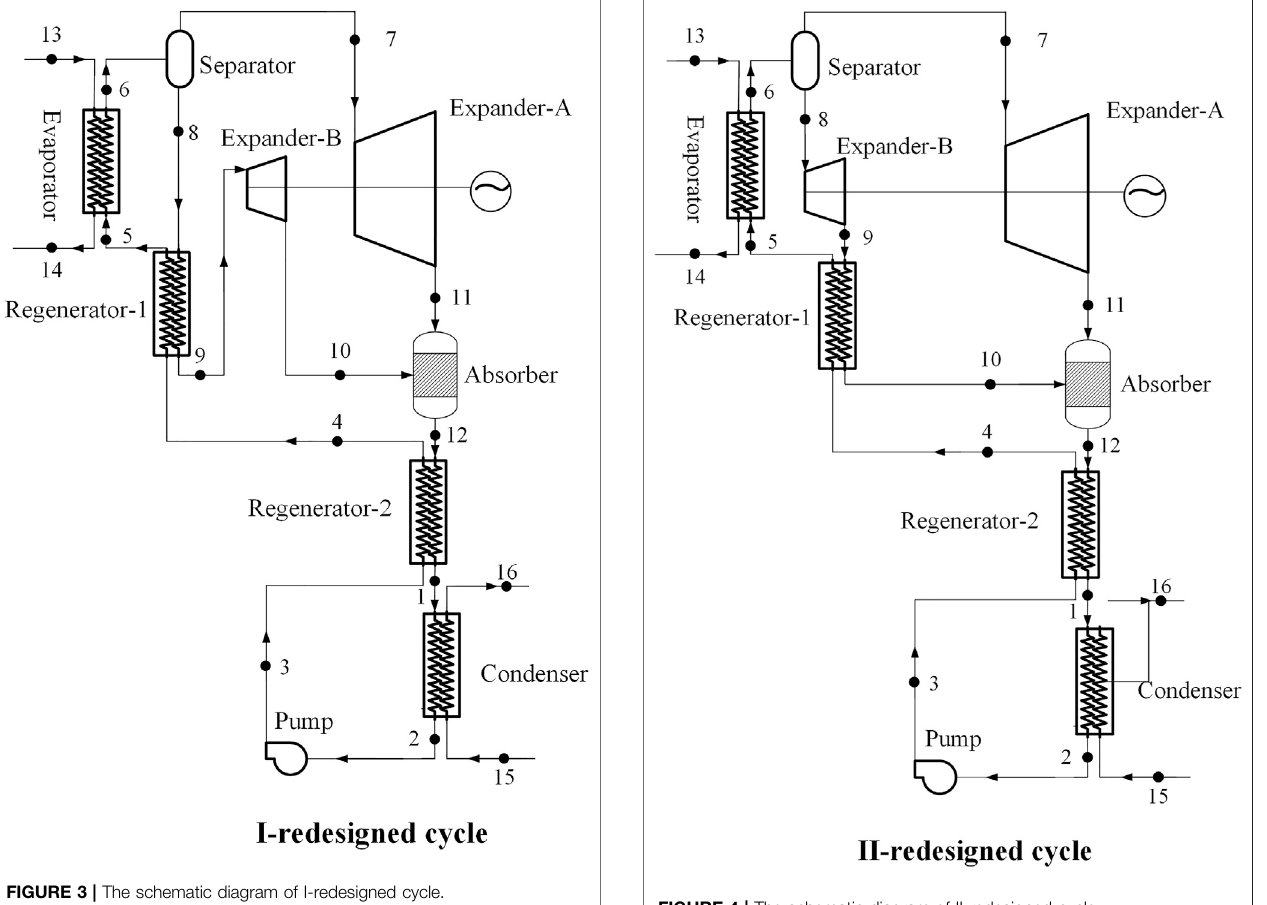
FIGURE 4 | The schematic diagram of II-redesigned cycle.